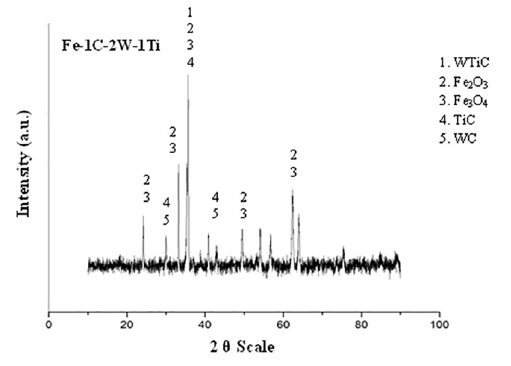
Figure 6. XRD spectra analysis of wear debris of Fe-1%C-2%W- 1%Ti hot extruded P/M alloy steel